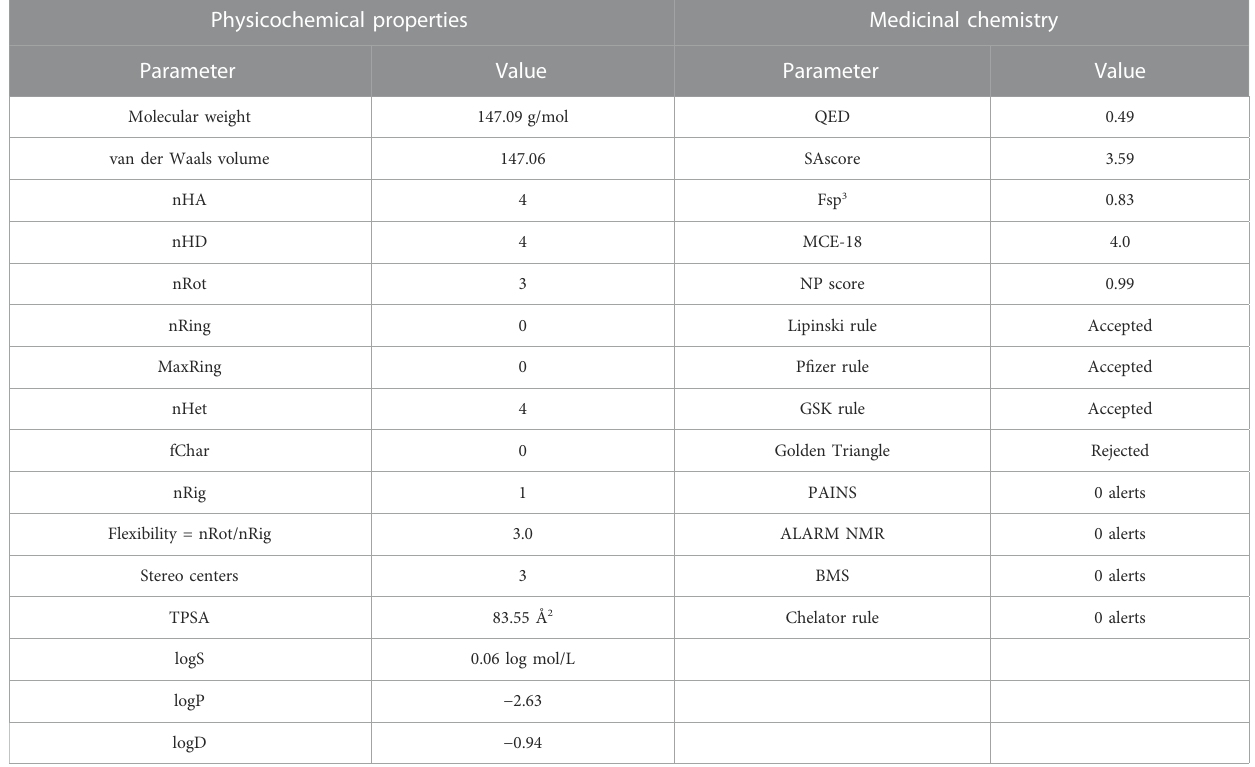
TABLE 2 Physicochemical properties and medicinal chemistry parameters of 4-hydroxy isoleucine calculated with ADMETLab 2.0. Physicochemical